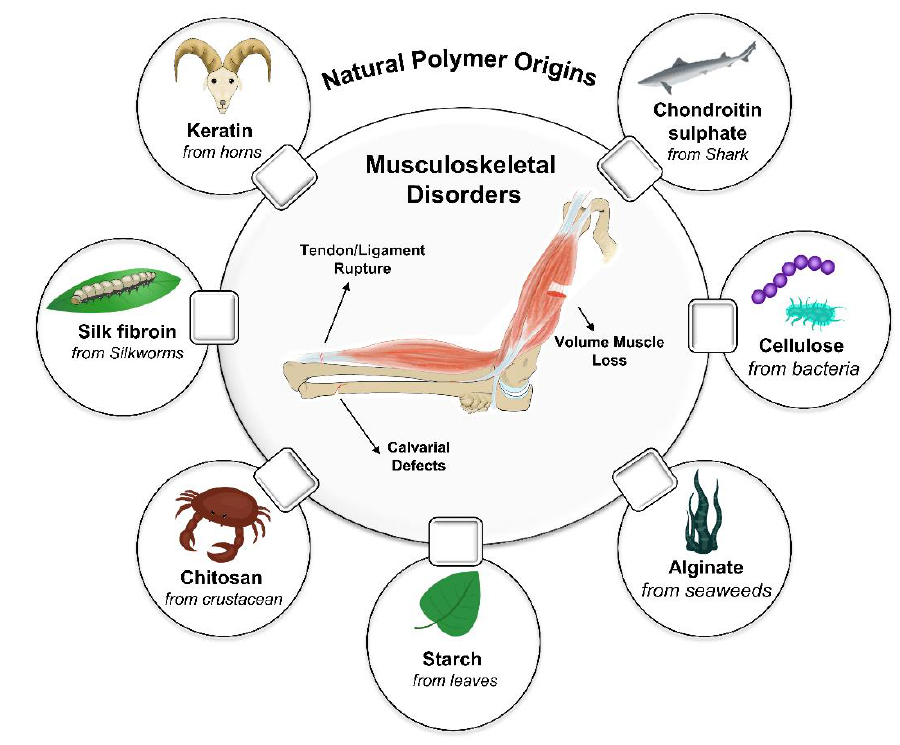
Figure 1. Schematic diagram of natural sources of natural polymers and their application in muscu- loskeletal tissue disorders.